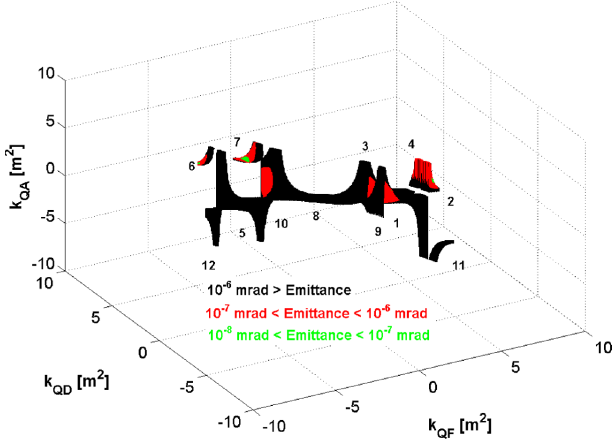
FIG. 15. (Color) Emittance of all linear stable solutions of one of the four CAMD DBA sectors plotted in k -space.